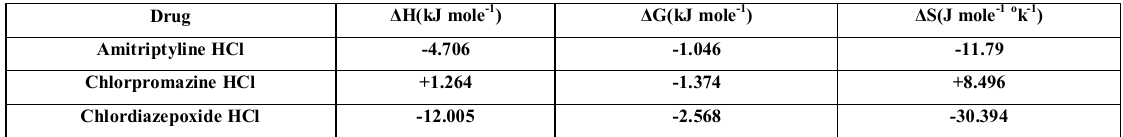
Table 2: Values of thermodynamic functions for the adsorption of the drugs on bentonite at 37.5 o C The adsorption of chlorpromazine-HCl on bentonite was found endothermic. This result agree